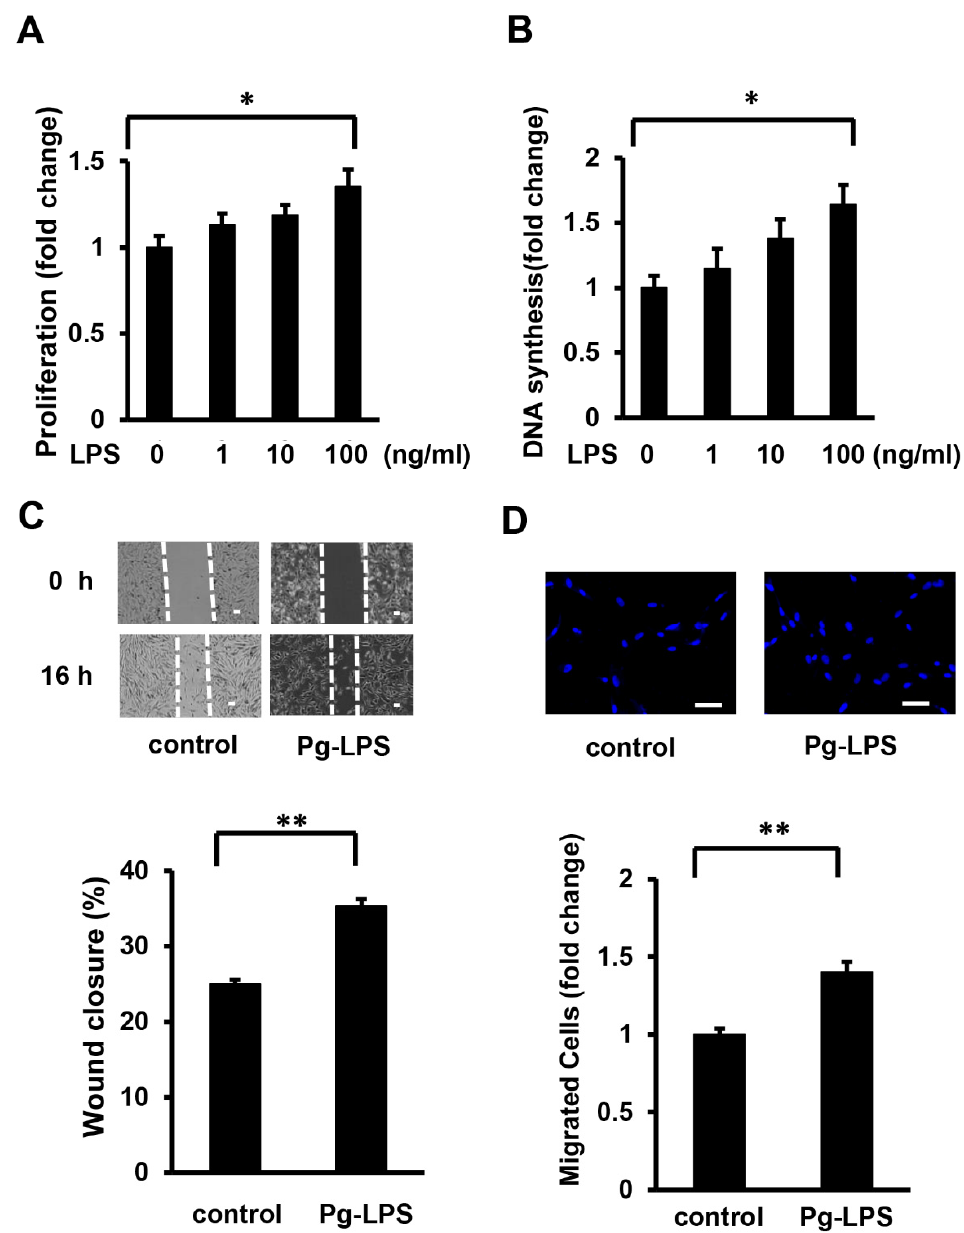
Figure 1. Pg -LPS induces HASMC proliferation and migration. ( A ) The effect of Pg -LPS on the number of HASMCs. HASMCs were treated with different concentrations (1, 10, and 100 ng/ml) of Pg -LPS for 16 h and evaluated using the MTT assay. n = 7 in each group. ( B ) The effect of Pg -LPS on HASMC DNA synthesis. HASMCs were treated with different concentrations (1, 10, and 100 ng/ml) of Pg -LPS for 16 h, and at the same time, cells were labeled with BrdU. n = 6 in each group. ( C ) The effect of Pg -LPS on HASMC migration. Upper panels show the representative scratch wound healing assay. The lower panel shows the quantitative analyses of wound closure rate. HASMCs were cultured in 6-well plates and directly scratched with a 200 μ L pipette tip. Cells were incubated with or without Pg -LPS (100 ng/mL) for 16 h. n = 6 in each group. The scale bar indicates 100 μ m. ( D ) Effect of Pg -LPS on the migratory property of HASMCs. The upper panels show the representative DAPI staining of migrated cells. HASMCs were seeded in a transwell and treated with or without Pg -LPS (100 ng/mL) for 16 h. n = 4 in each group. The scale bar indicates 50 μ m. * p < 0.05 vs. basal; ** p < 0.01 vs. basal. Data are presented as mean ± SE.